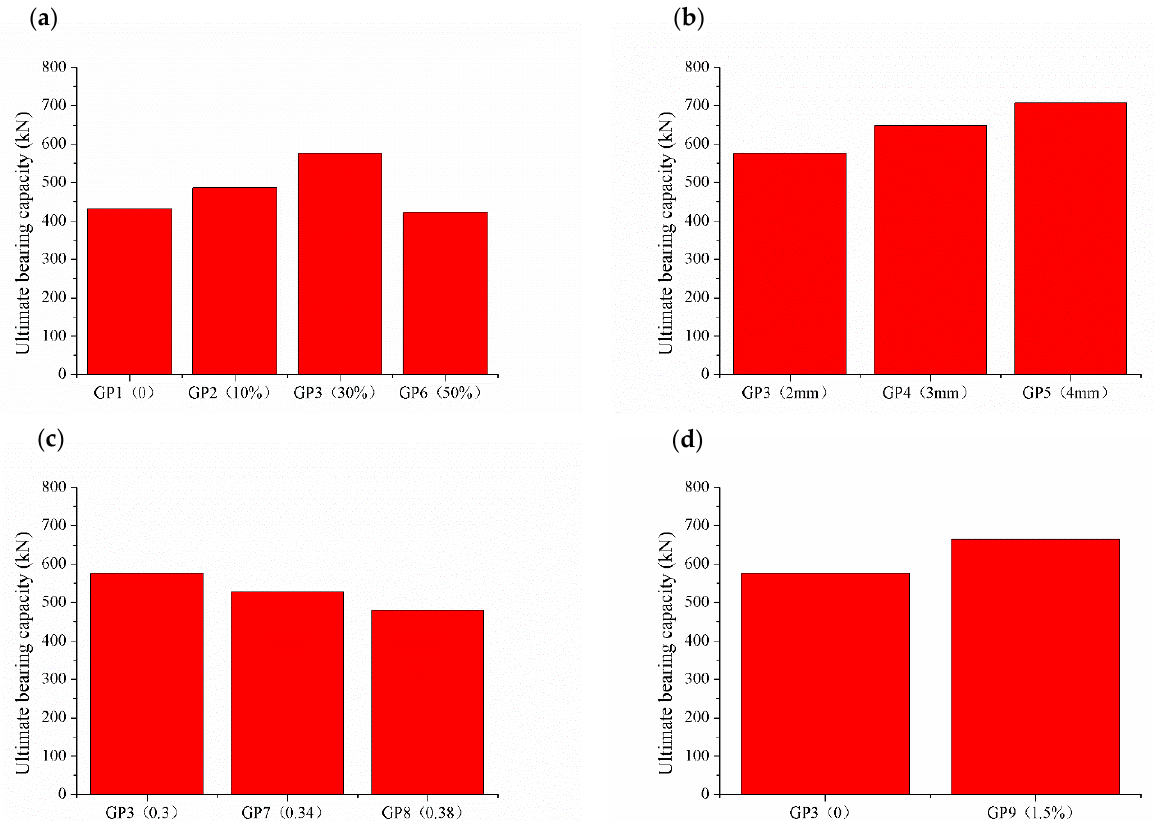
Figure 9. Different influence factors on the ultimate bearing capacity of CFSTs. ( a ) amount of GDS; ( b ) wall thickness; ( c ) W/B; and ( d ) amount of sodium sulfate.